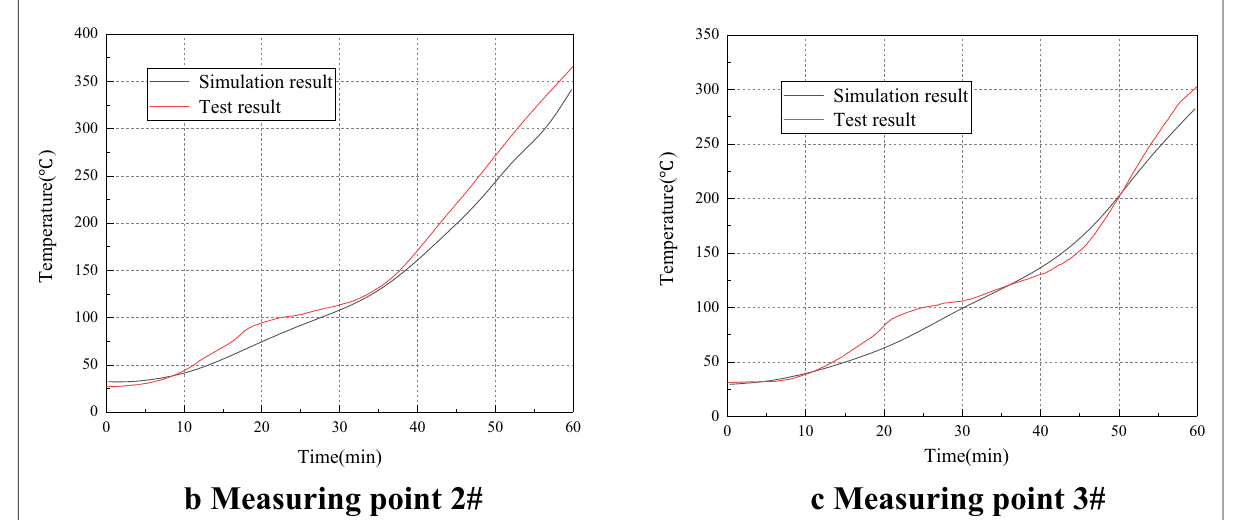
Fig. 12 Temperature measuring points and simulated